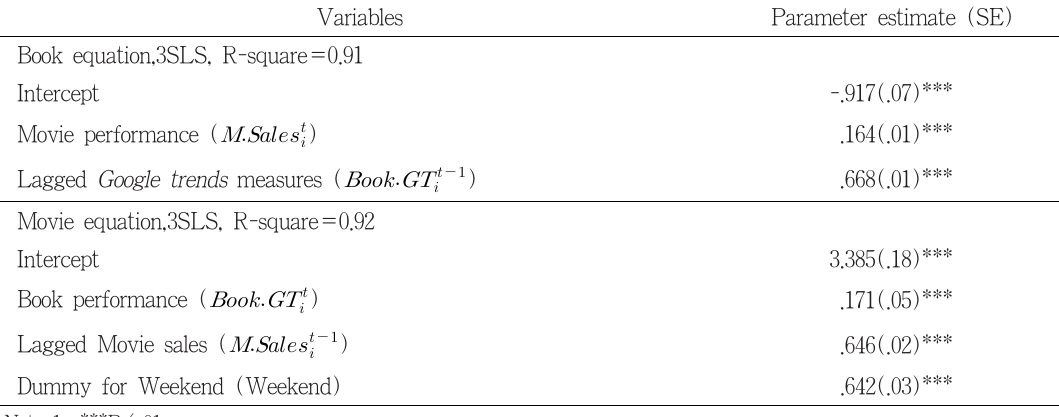
<Table 2> Estimates of Simultaneous Equations models: Time-Series